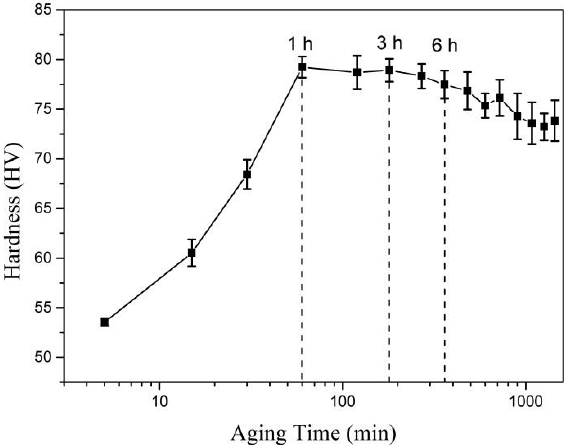
Figure 1. Evolution of hardness of the specimens artificially aged at 210 °C.